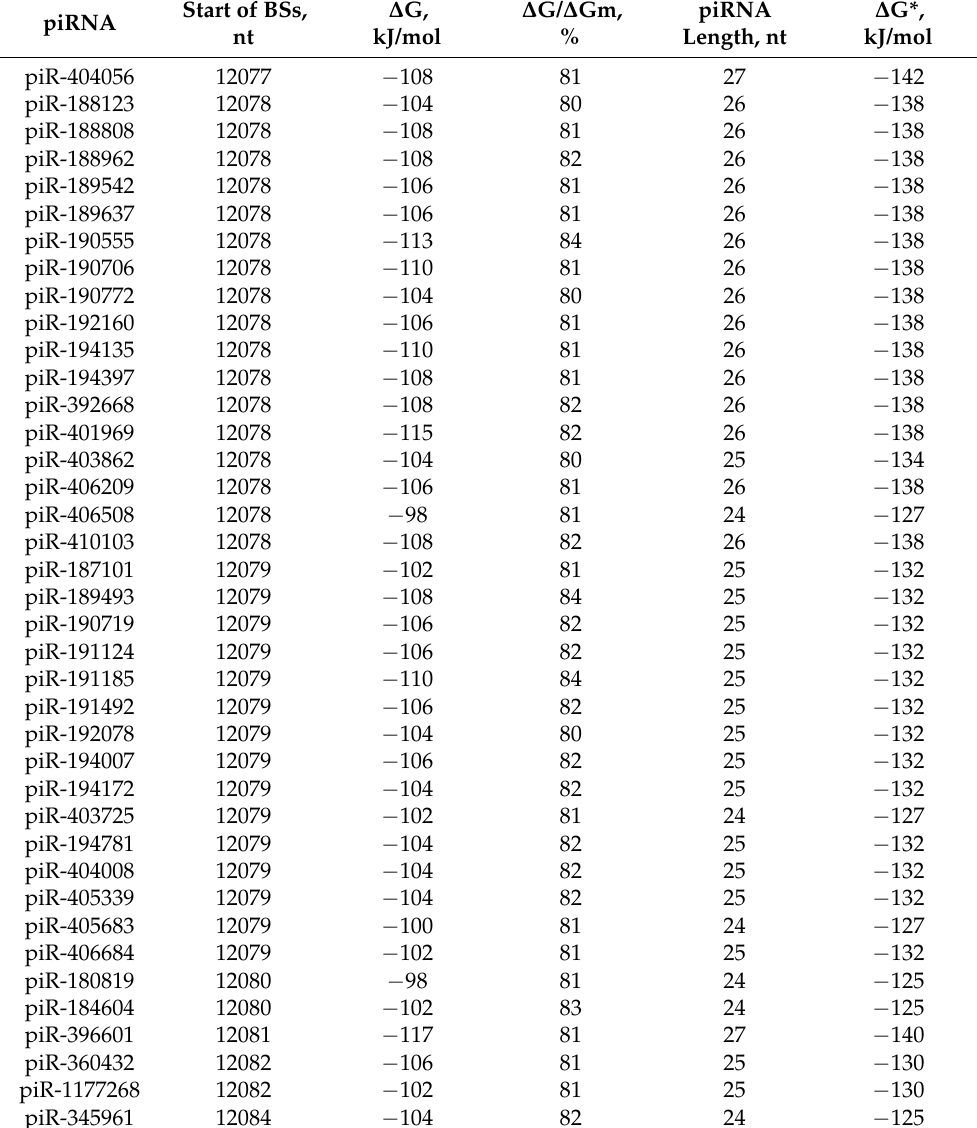
Table 1. Characteristics of the interaction of 39 piRNAs and spiRNAs with the BS RNA cluster of SARS-CoV-2 from 12077 nt to 12107